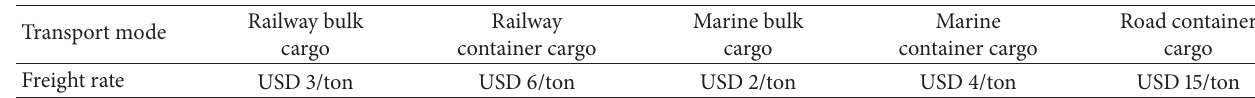
Table 4: Freight rates of various transportation modes.